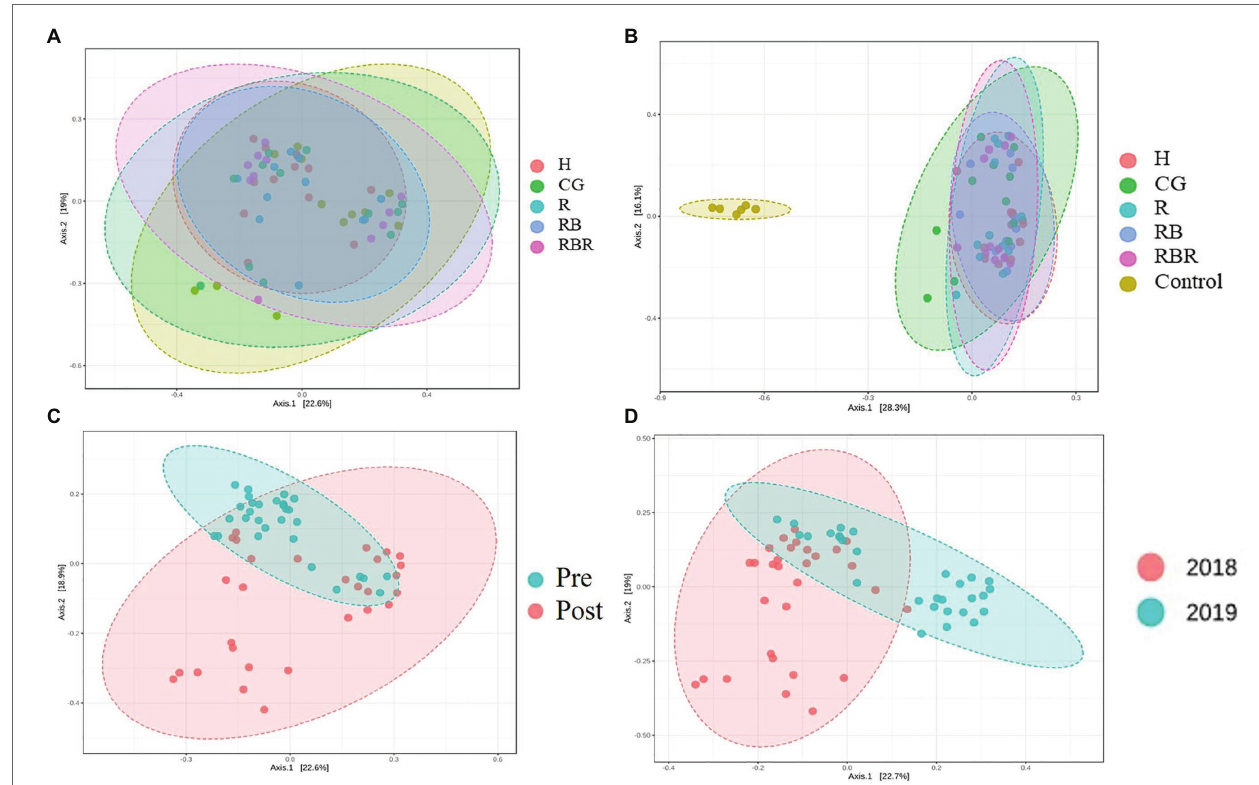
FIGURE 4 | The beta diversity of bacterial community impact by pasture management [without (A) or with control samples (B) ], sampling collection timing (pre and post poultry litter surface application; C ) and year (2018 and 2019; D ) in water samples. Treatments included: hayed (H), continuously grazed (CG), rotationally grazed (R), rotationally grazed with a buffer strip (RB), and rotationally grazed with a fenced riparian buffer (RBR).